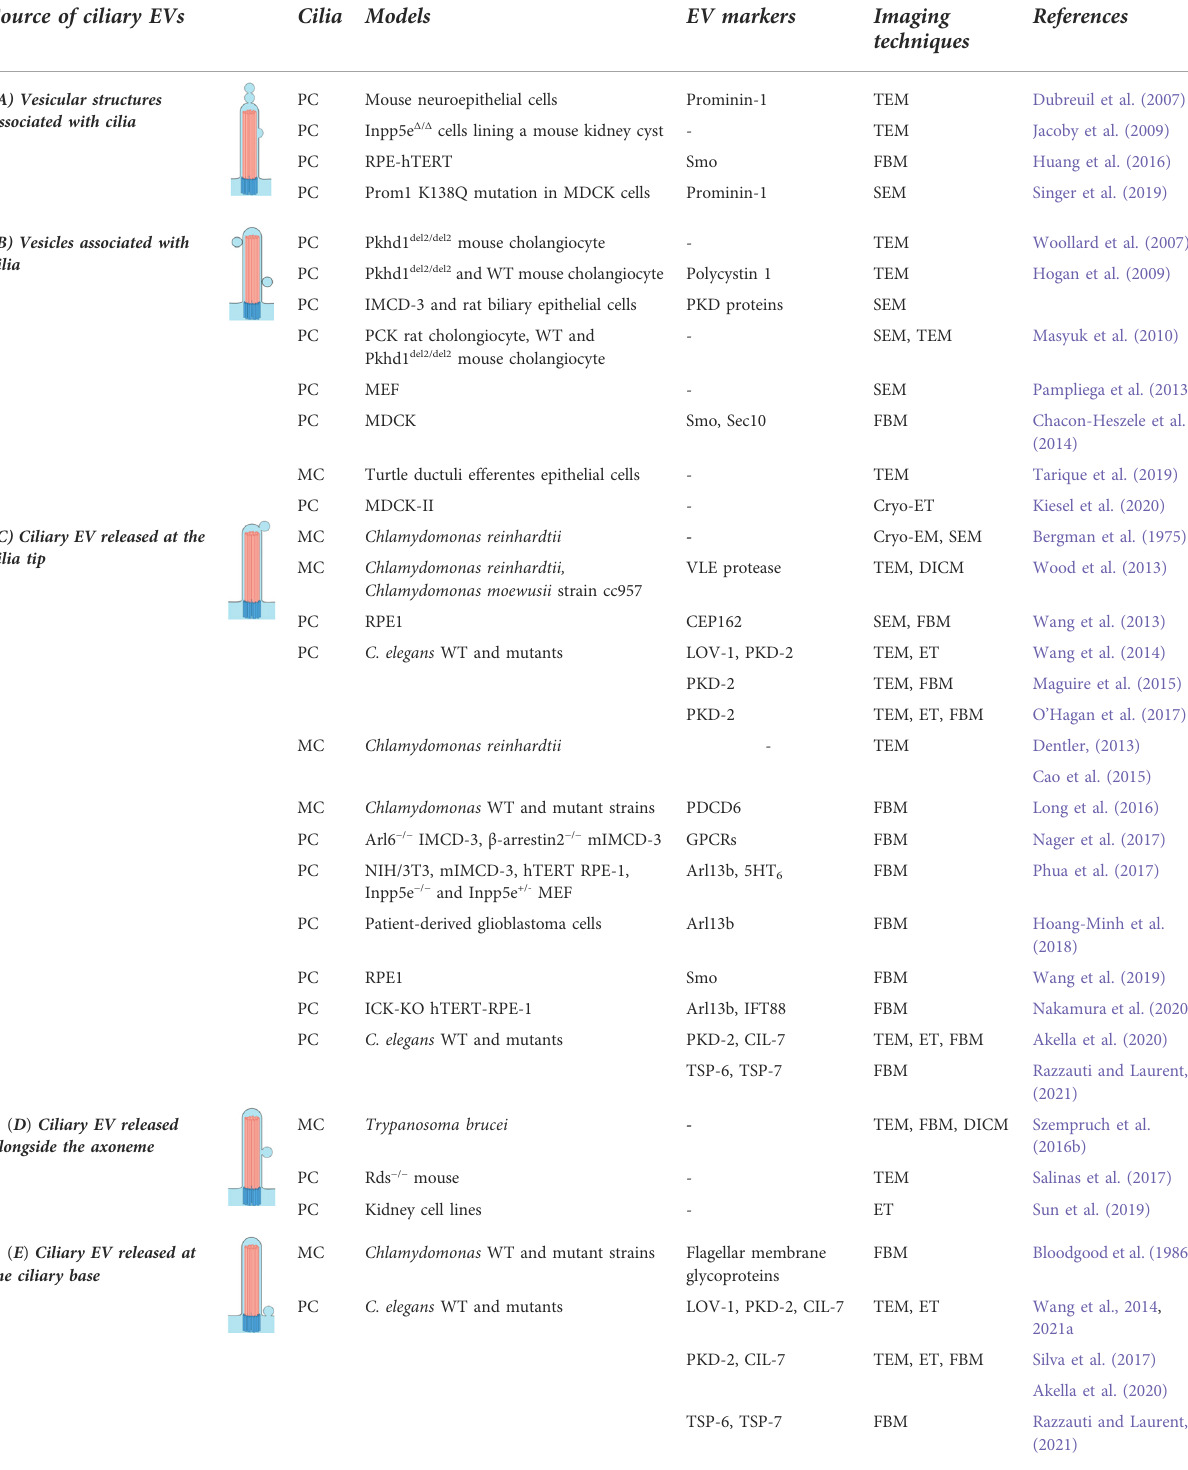
TABLE 1 Microscopic analysis revealed the presence of (A) cilia deformations ( e.g., bulb at the tip, membrane bud); (B) vesicles or vesicle-like structures associated with cilia (C) ciliary EVs generated at the ciliary tip (D) alongside the axoneme, or (E) the ciliary